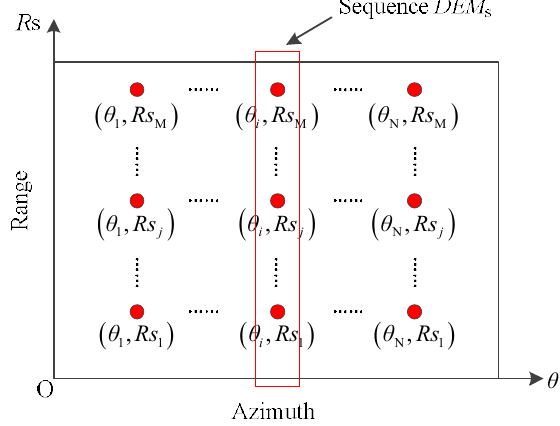
Figure 8. The DEM image in the polar coordinate system.